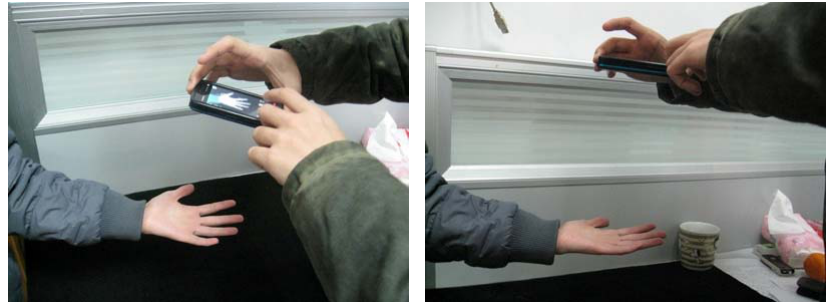
Figure 2. The scenes of non-contact palmprint image acquisition in this